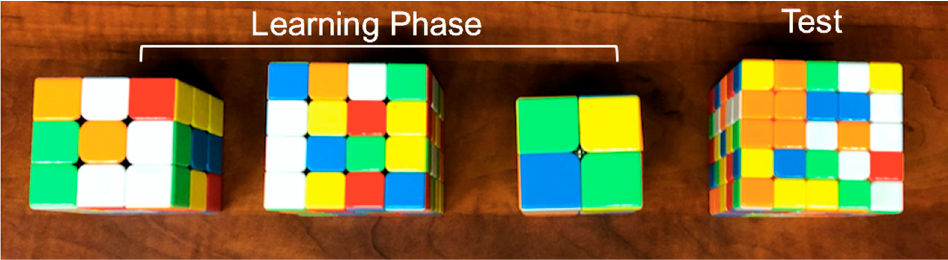
Figure 3. Variable-order condition example. Cubes vary in size during the learning phase (here, 3 × 3 × 3; 4 × 4 × 4, 2 × 2 × 2) before the test (5 × 5 × 5).